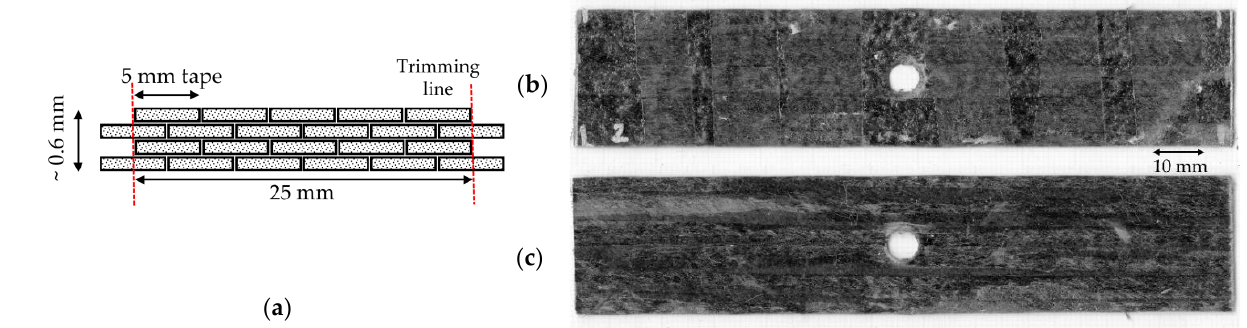
Figure 10. ( a ) Stacking sequence of the layup sample showing four layers with trimming lines to make a 25 mm wide sample; an example of a layup part with a cutting hole using a hollow punching tool: ( b ) top surface and ( c ) bottom surface (attached to the metallic mould) [25].